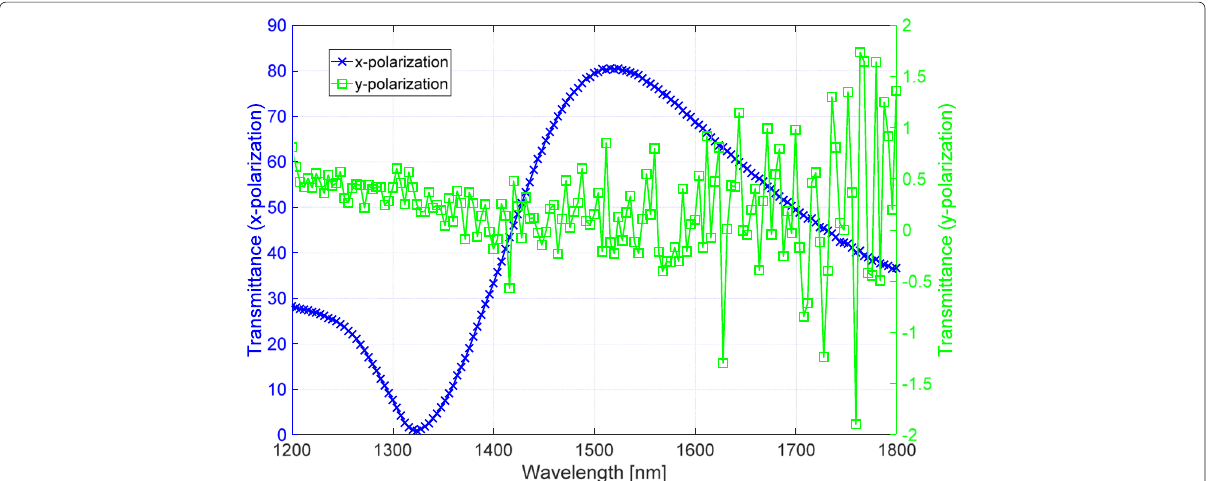
Fig.4 Transmittance spectra measured by the spectrophotometer. The blue and green lines are the spectra for the x and y polarizations,